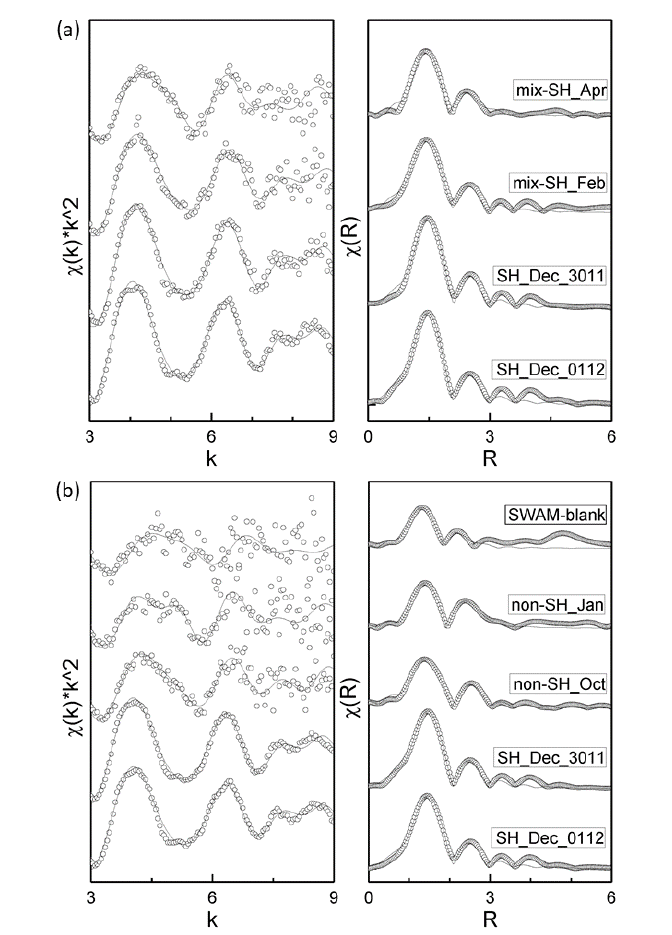
Figure 3. Lefthand panels show EXAFS spectra of ( a ) Saharan dust PM 10 samples (SH_Dec_3011 and SH_Dec_0112) and mixed Saharan PM 10 samples (mix-SH_Feb and mix-SH_Apr); ( b ) Saharan dust PM 2.5 samples (SH_Dec_3011 and SH_Dec_0112), non Saharan PM 2.5 samples (non-SH_Oct and non-SH_Jan) and SWAM blank filter. Fourier transformed spectra fits are reported in the corresponding righthand panels. Herein the open circles are the experimental points and the lines the model best fits (see